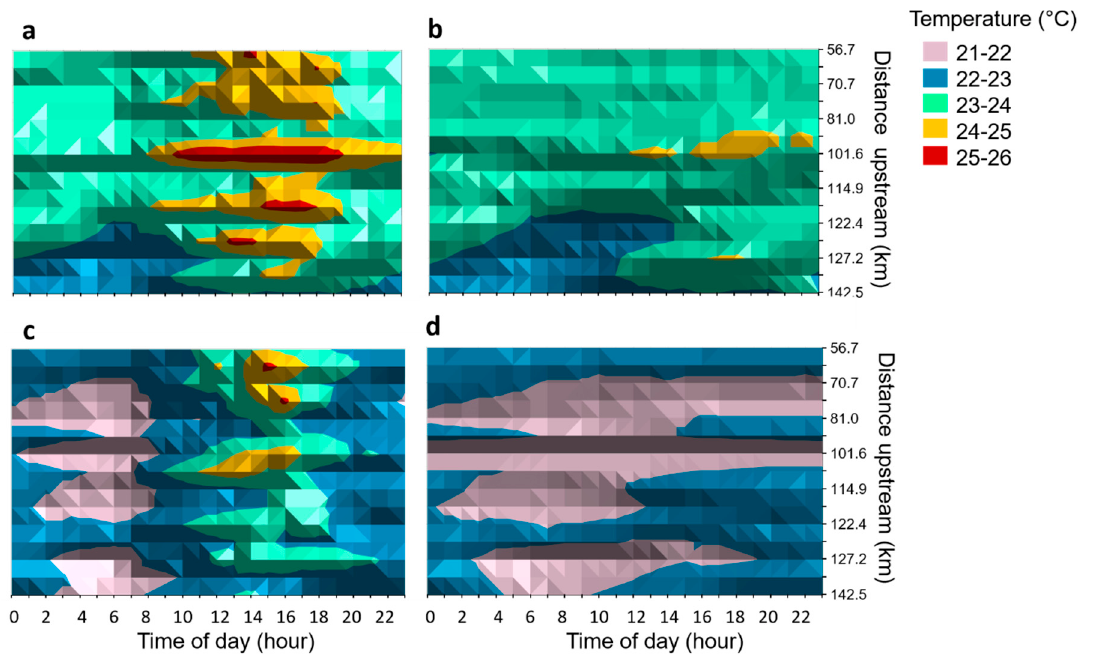
Figure 5. Hourly water temperature near the surface ( a ) and bottom ( b ) for 23 July 2017 and surface ( c ) and bottom ( d ) for 27 August 2017 along the longitudinal profile of the Pend Oreille River. Values were interpolated between sites and times. Y-axes indicate river kilometer locations and are not scaled linearly. These days were selected because both days had a maximum air temperature of 33.3 ◦ C but they had di ff erent diel patterns. On 27 August, air temperature was 3 ◦ C cooler in the morning than on 23 July.